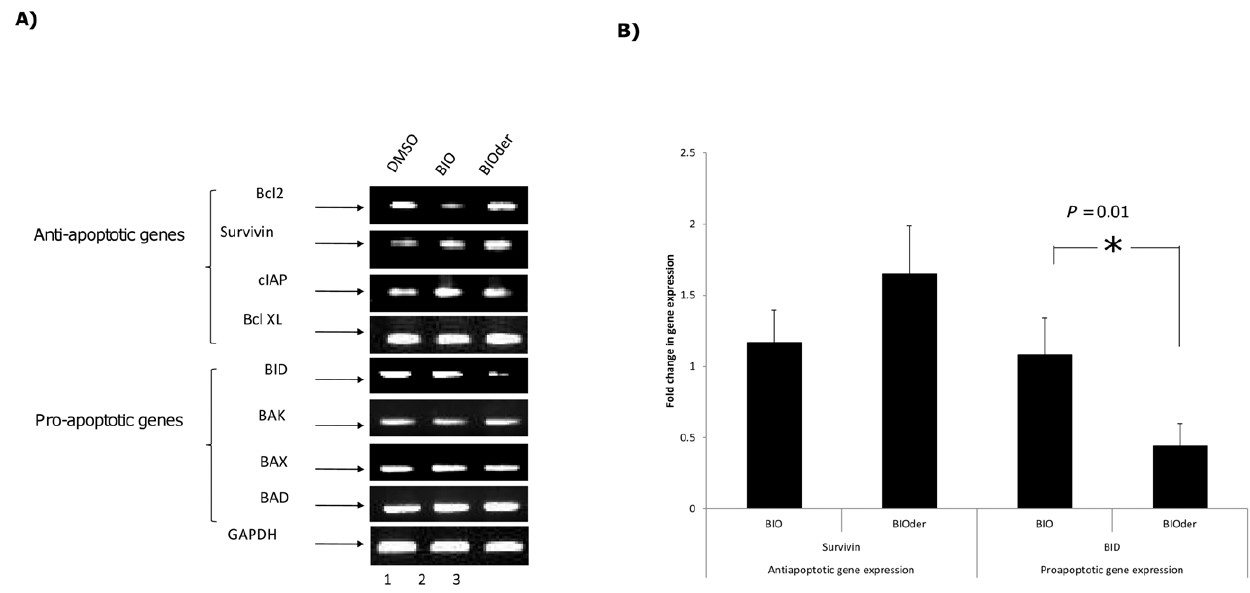
Figure 6. BIOder treatment alters expression of apoptotic genes to promote survival of U87MGs. A ) U87MGs were treated with 1 m M BIO, 1 m M BIOder, or DMSO and infected with VEEV TC-83. RNA was harvested from infected cells 24 hours post infection and analyzed by RT-PCR for expression of the indicated anti- and pro-apoptotic genes. B ) Band intensities corresponding to triplicate samples were quantified and represented as fold change in gene expression over the DMSO control, with the DMSO control being set as a fold change of 1.0.